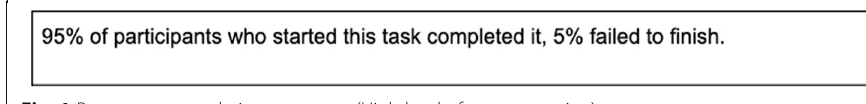
Fig. 1 Percentage completion statement (High level of success